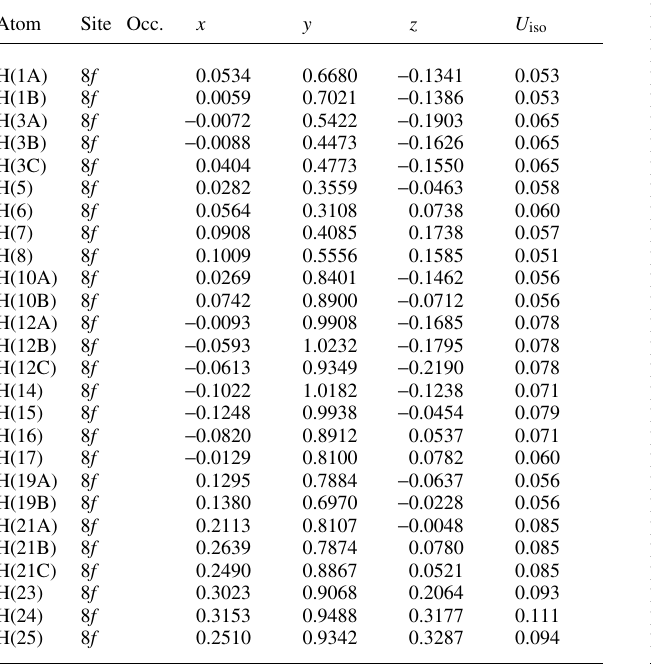
Table 2. Atomic coordinates and displacement parameters (in Å 2 ) .